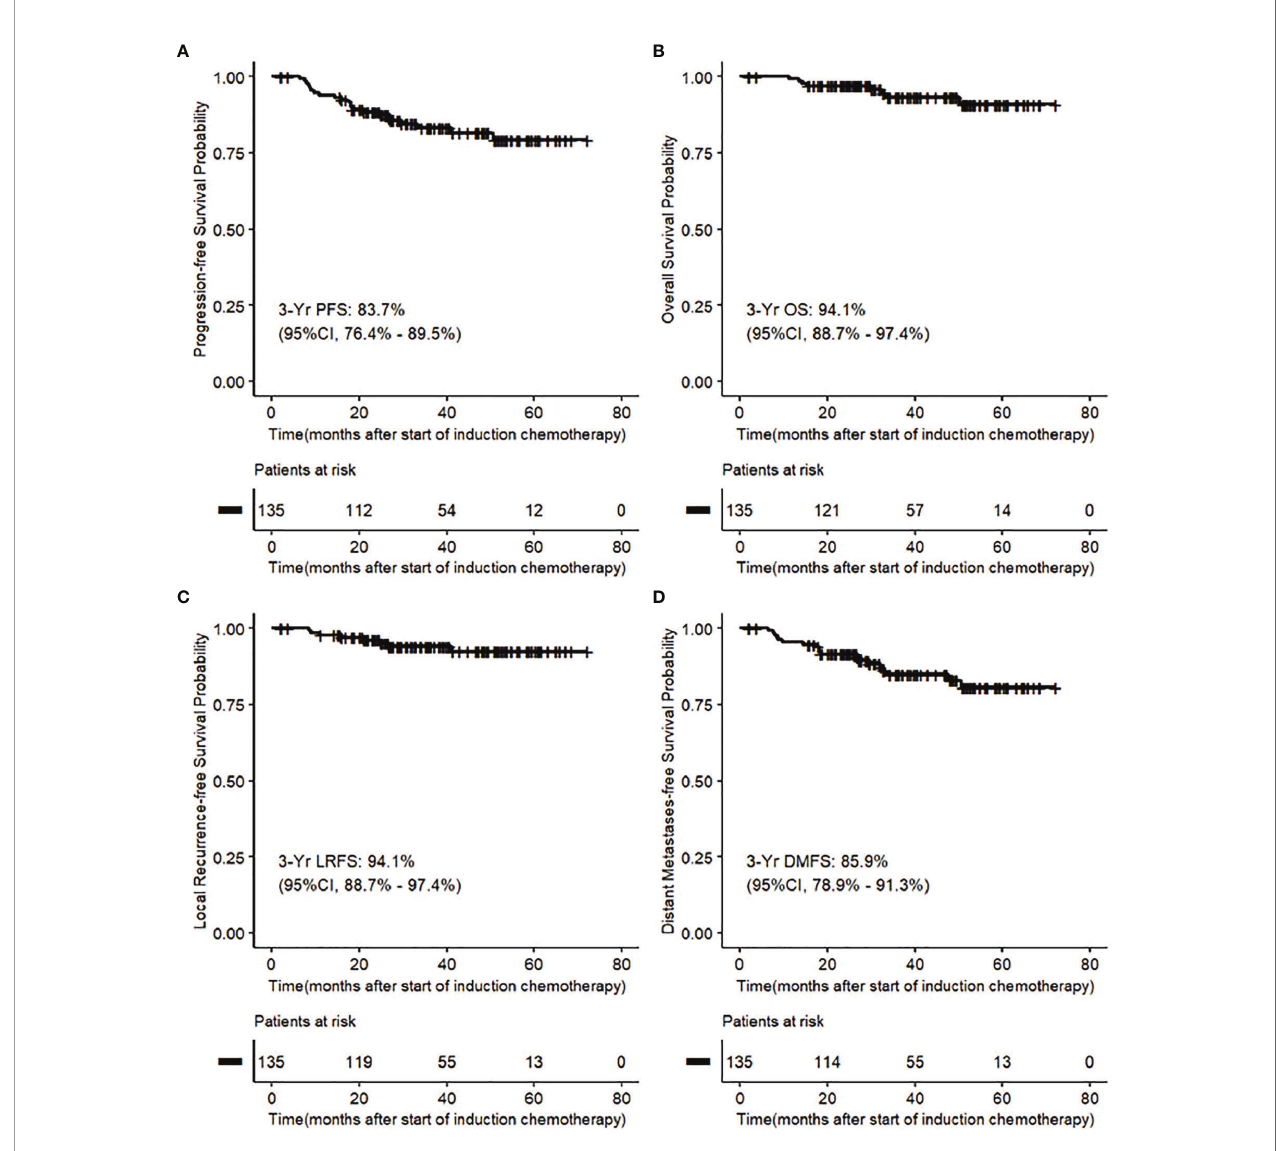
FIGURE 2 | (A-D) Kaplan – Meier Analysis of survival outcomes in intention-to-treat